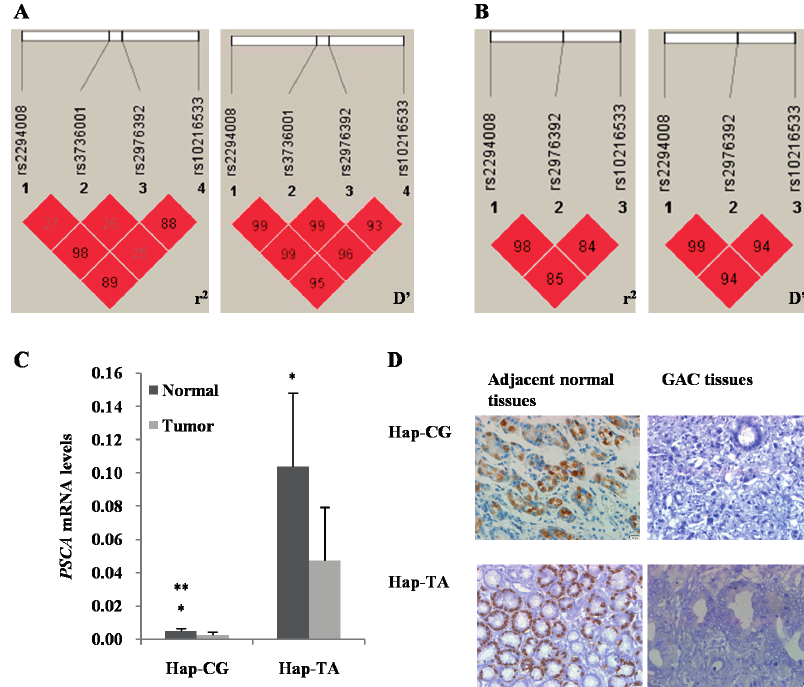
Figure 1. Linkage disequilibrium (LD) and PSCA expression analysis. ( A ) LD of four SNPs in PSCA gene (rs2294008, rs3736001, rs2976392 and rs10216533); ( B ) LD of three SNPs in PSCA gene (rs2294008, rs2976392 and rs10216533). Values in squares were the pair-wise calculation of r 2 ( left ) and D ’ ( right ); ( C ) qRT-PCR results showed a significant decrease